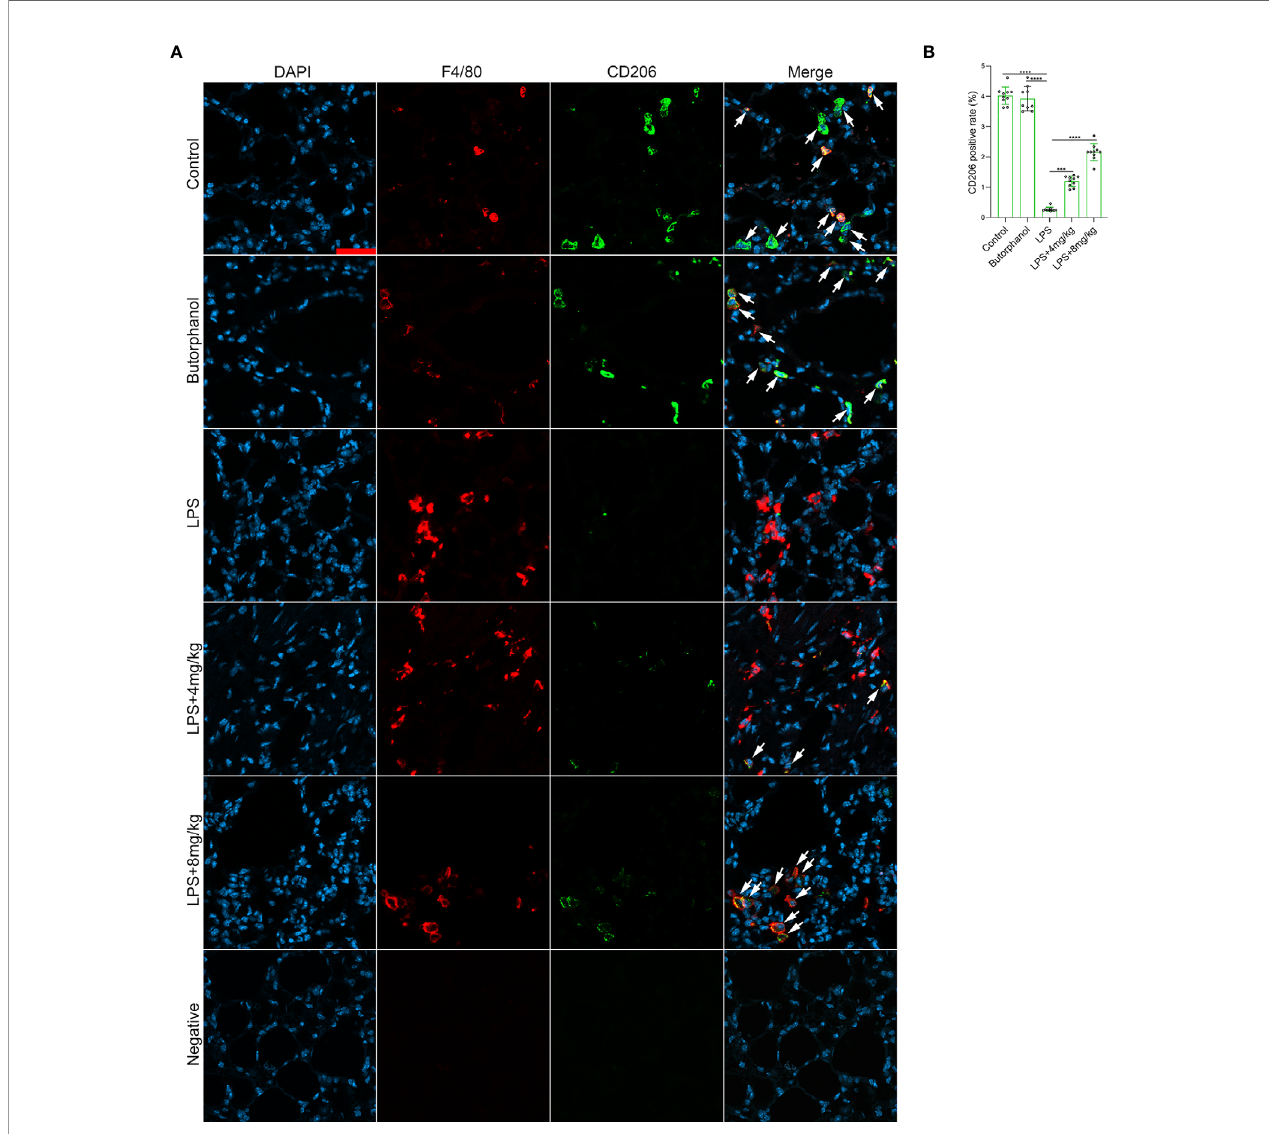
FIGURE 3 | Butorphanol administration promoted M2 macrophage polarization in LPS-induced lung injury. Mice were injected with LPS ( 10 mg·kg -1 i.p.) or butorphanol (8 mg·kg -1 i.p.) or butorphanol (4 mg·kg -1 i.p. or 8 mg·kg -1 i.p.) plus LPS (10 mg·kg -1 i.p.) and analyzed after 24 h. (A) Sections were stained with antibodies against F4/80 (red) and CD206 (green). Scale bar: 25 m m. (B) The image analysis results are presented as the percentage of CD206-positive F4/80 cells. The results are the means ± SEM of ten independent experiments. Statistical analysis was performed by one-way ANOVA followed by Tukey ’ s post hoc test when comparing multiple independent groups. ***P < 0.001, ****P <